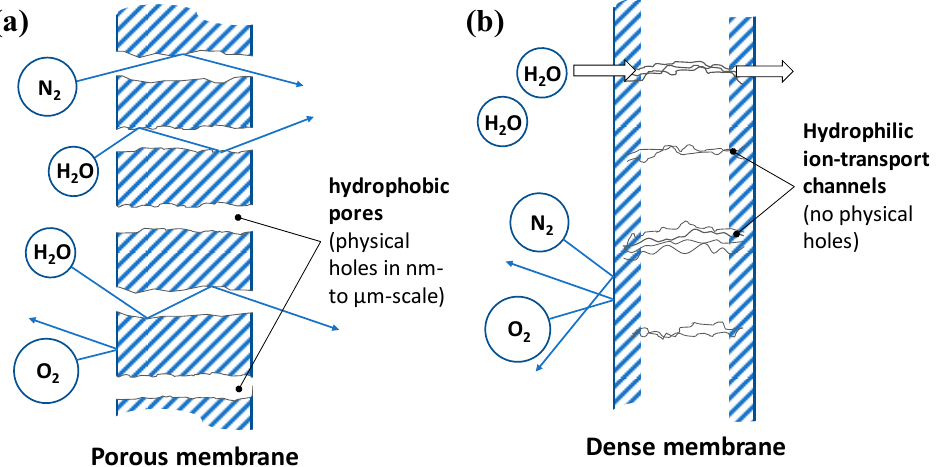
Figure 1. Water vapor permeation through ( a ) porous membrane ( b ) dense membrane.